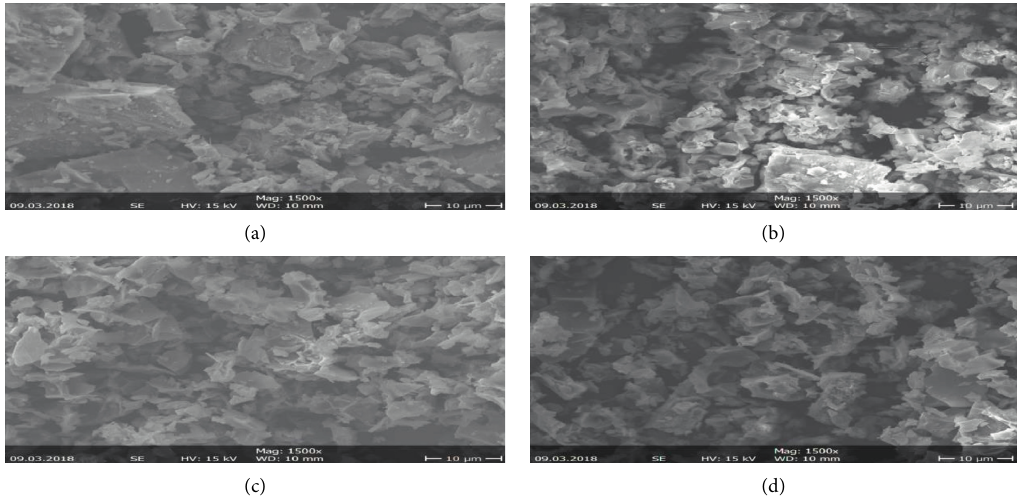
Figure 6: Morphology of samples: (a) precursor-RM, (b) NIC, (c) ACPA, and (d) ACPH.